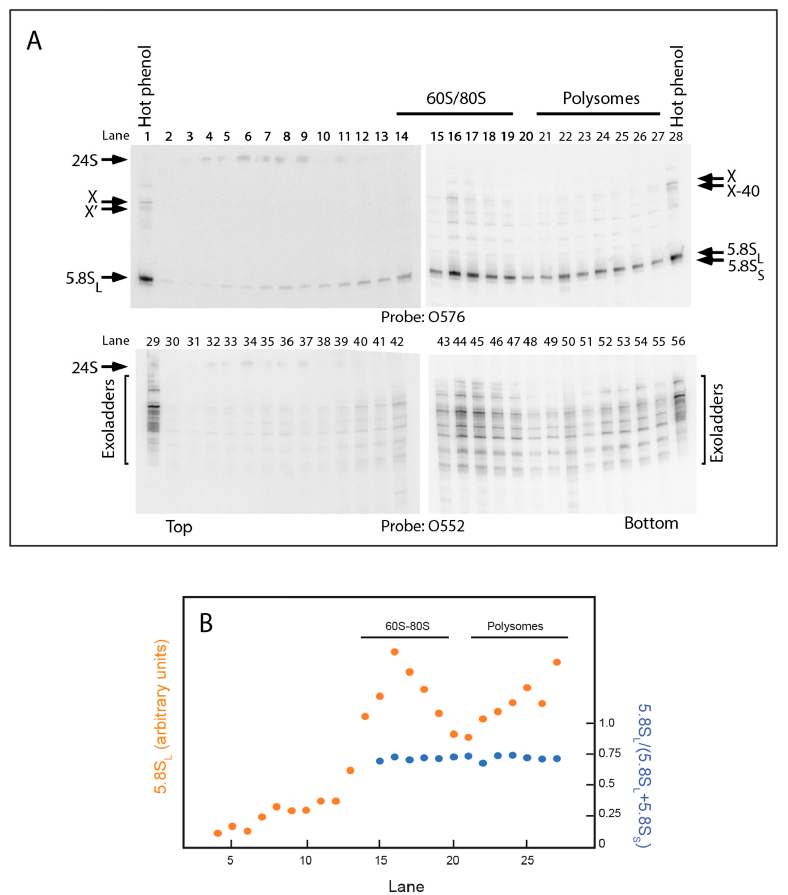
Figure 8. 5 ′ extended 5.8S rRNA is incorporated into 60S, 80S and polysomal ribosomes. ∆ rpa12 ∆ xrn1 carrying pDK16-tag ∆ 2 rRNA genes was grown at 25° and shifted to 37° for 6 h. Whole cell extracts were fractionated on sucrose gradients. RNA was then isolated from each fraction and subjected to acrylamide gel electrophoresis. Finally, RNA was transferred to nylon blots and probed with O576 or O552. ( A ) Northern blots. ( B ) Quantification of 5.8S L (orange) and the L-fraction (5.8S L /(5.8S L + 5.8S S ) across the